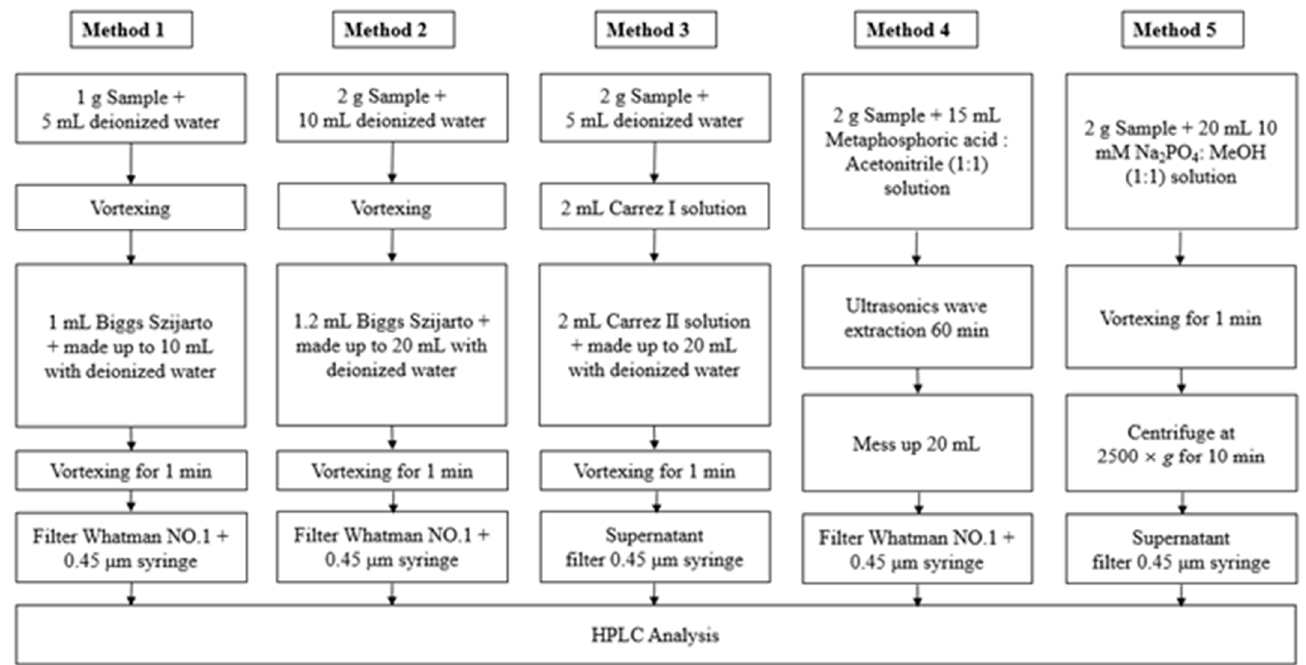
Figure 1. Comparison of the analytical steps required for determining steviol glycoside content in fermented milk